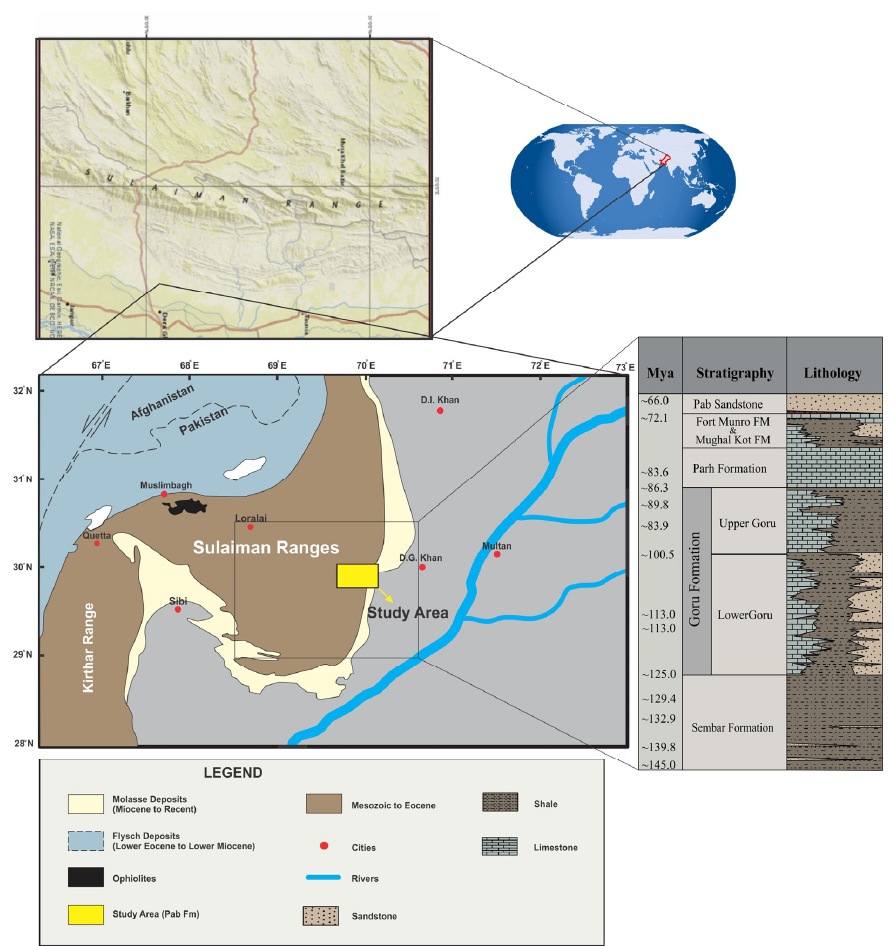
Figure 1. Map showing the outcrop belt of the Pab Sandstone in the Rakhi gorge, Eastern Sulaiman range of Pakistan, inset shows the generalized stratigraphic column.